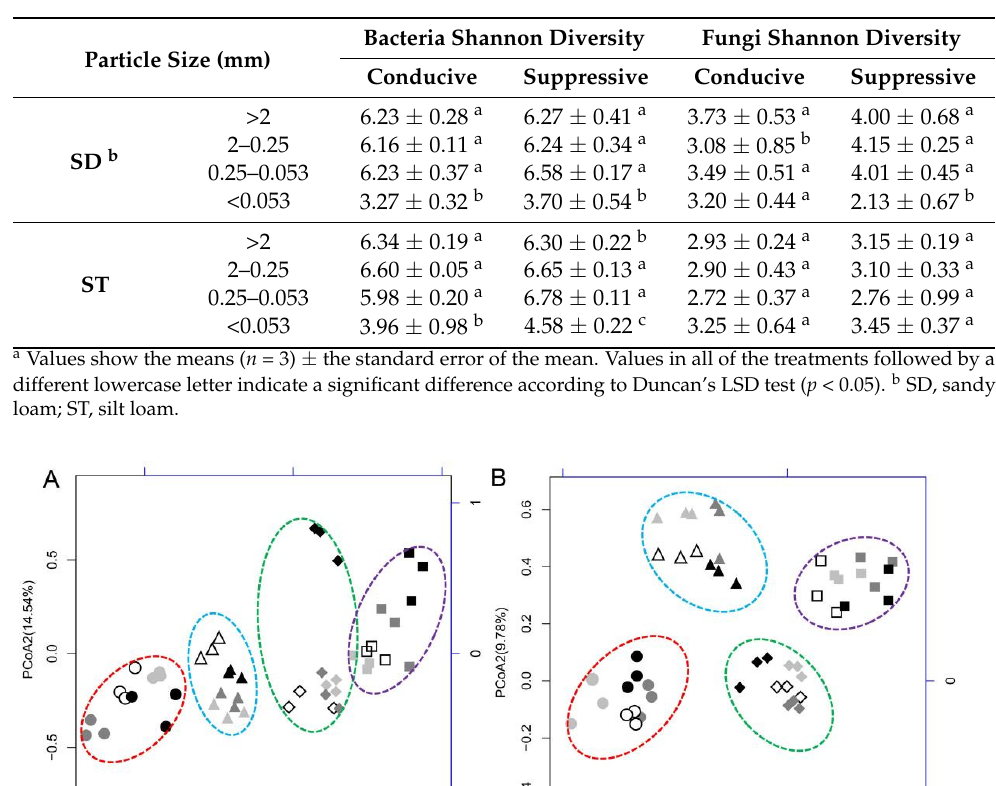
Table 2. The Shannon indexes of bacterial and fungal communities in different soil fractions a .